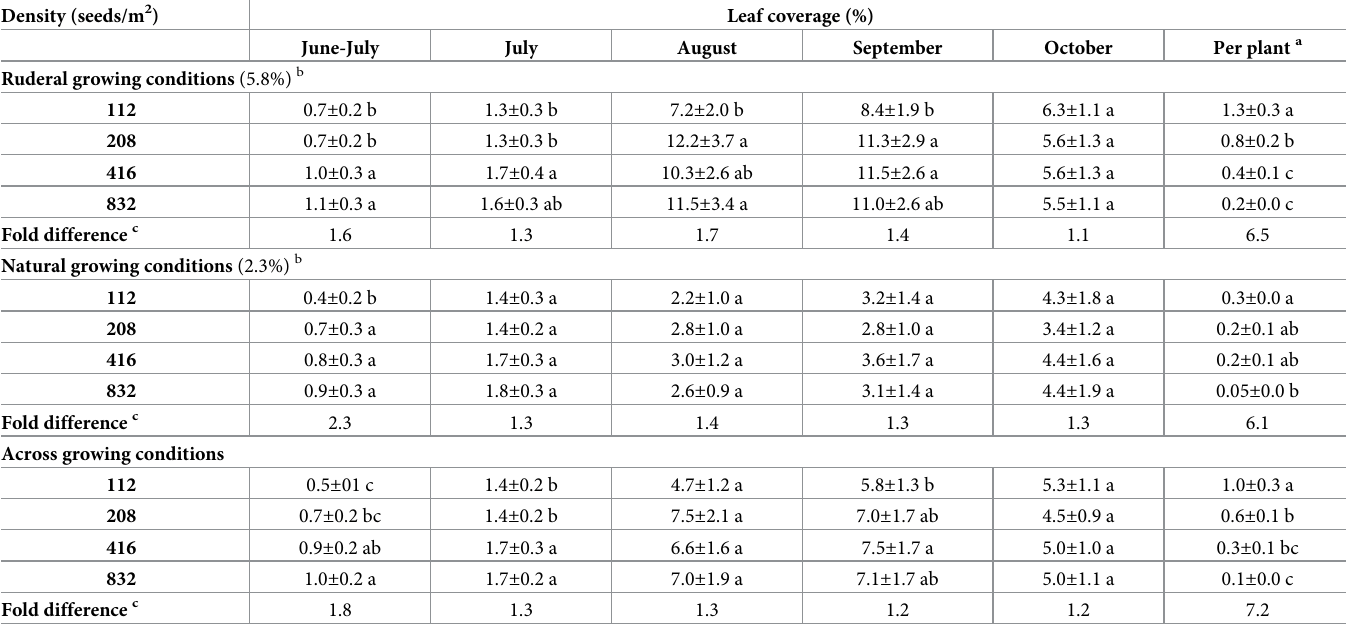
For each growing condition and leaf coverage observation, significant differences at 0.05 level among plant densities are designated by different letters. a Wild soybean leaf coverage per plant at the end of the season. b Mean leaf coverage values of wild soybean during the season. c Fold difference between minimum and maximum values observed for different planting